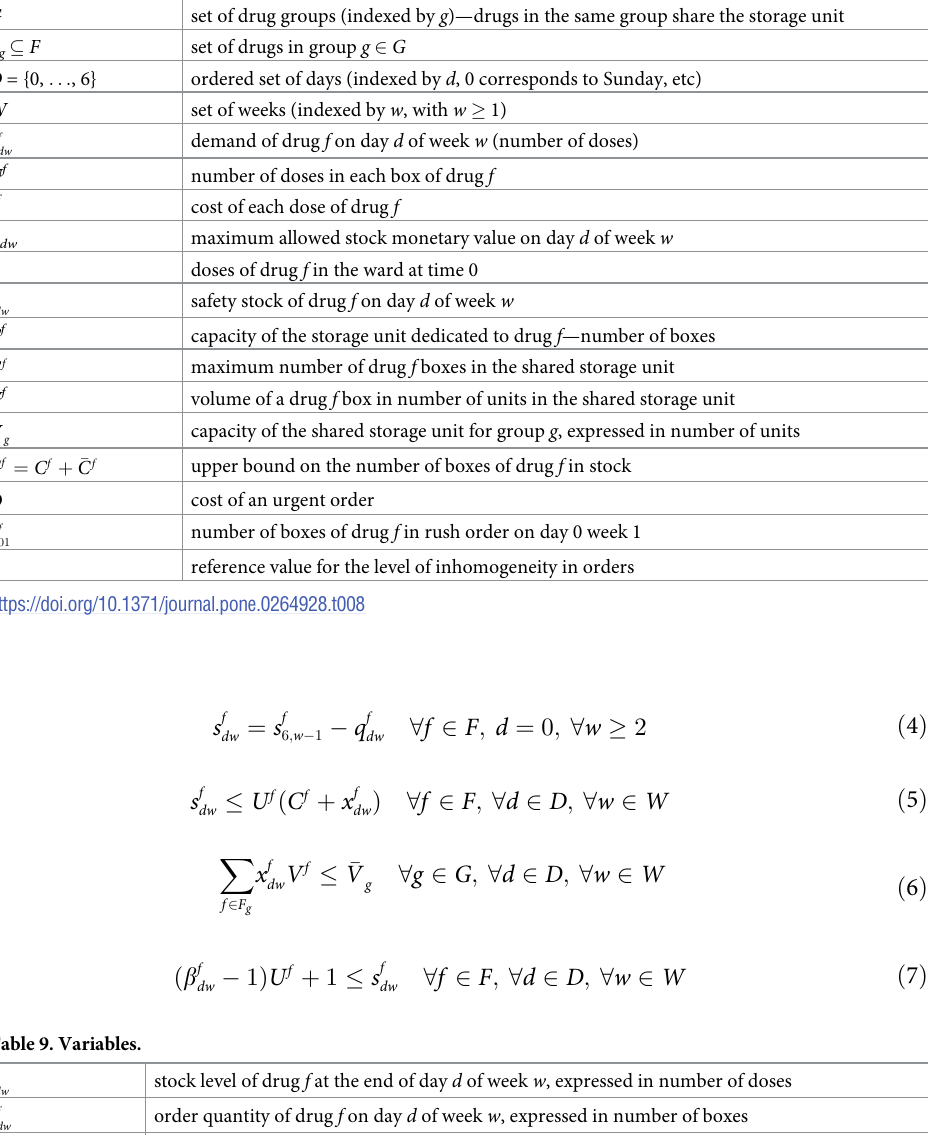
Table 9. Variables. stock level of drug f at the end of day d of week w , expressed in number of doses order quantity of drug f on day d of week w , expressed in number of boxes equal to 1 when a standard order of drug f occurs on day d of week w ; 0 otherwise equal to 1 when a standard order occurs on day d of week w ; 0 otherwise equal to 1 when an urgent order of drug f occurs on day 0 of week 1; 0 otherwise order quantity of drug f , expressed in number of boxes number of boxes of drug f in the shared storage unit on day d of week w number of boxes of drug f in the dedicated storage unit on day d of week w number of boxes of drug f in stock at the end of day d of week w equal to 1 if the storage unit dedicated to drug f is full on day d of week w maximum number of drugs in an order over the planning period minimum number of drugs in an order over the planning period